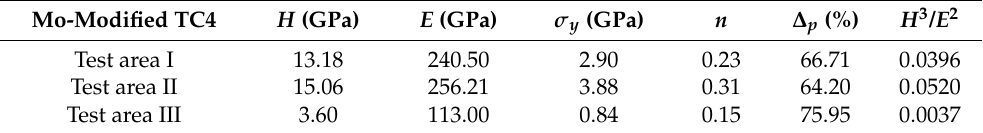
Table 4. Elasto-plastic parameters extracted from load-displacement curves of I, II and III.